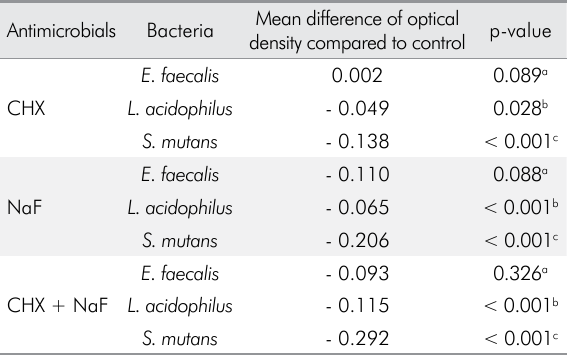
Table 2. The effect of antimicrobials in the optical density of bacterial growth Antimicrobials